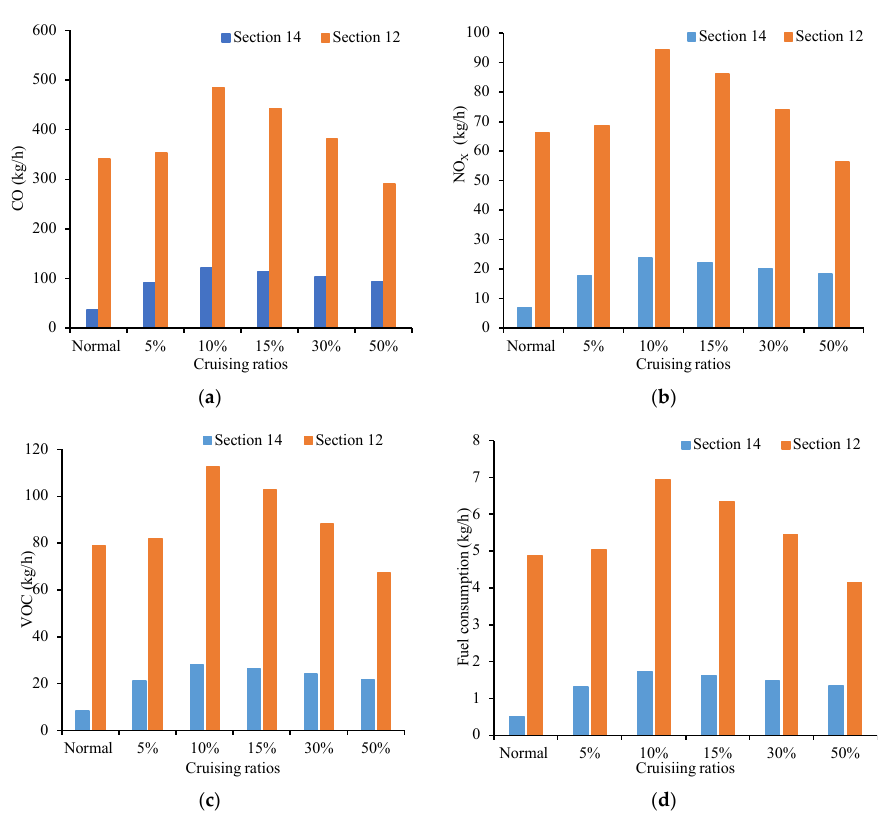
Figure 21. Comparison of Section 14 and Section 12 emission. ( a ) Comparison of CO emission under Section 14 and Section 12. ( b ) Comparison of NO X emission under Section 14 and Section 12. ( c ) Comparison of VOC emission under Section 14 and Section 12. ( d ) Comparison of fuel consumption under Section 14 and Section 12.